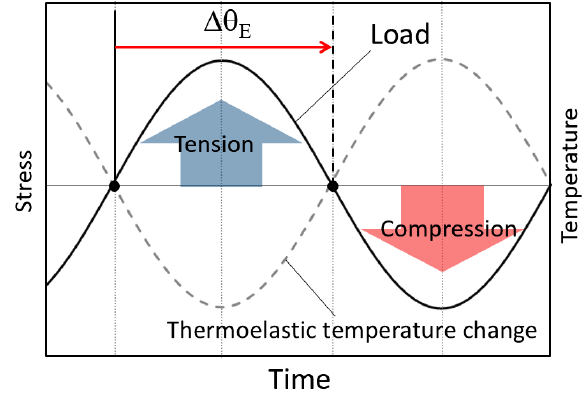
Figure 1. Definition of phase in thermoelastic temperature change.